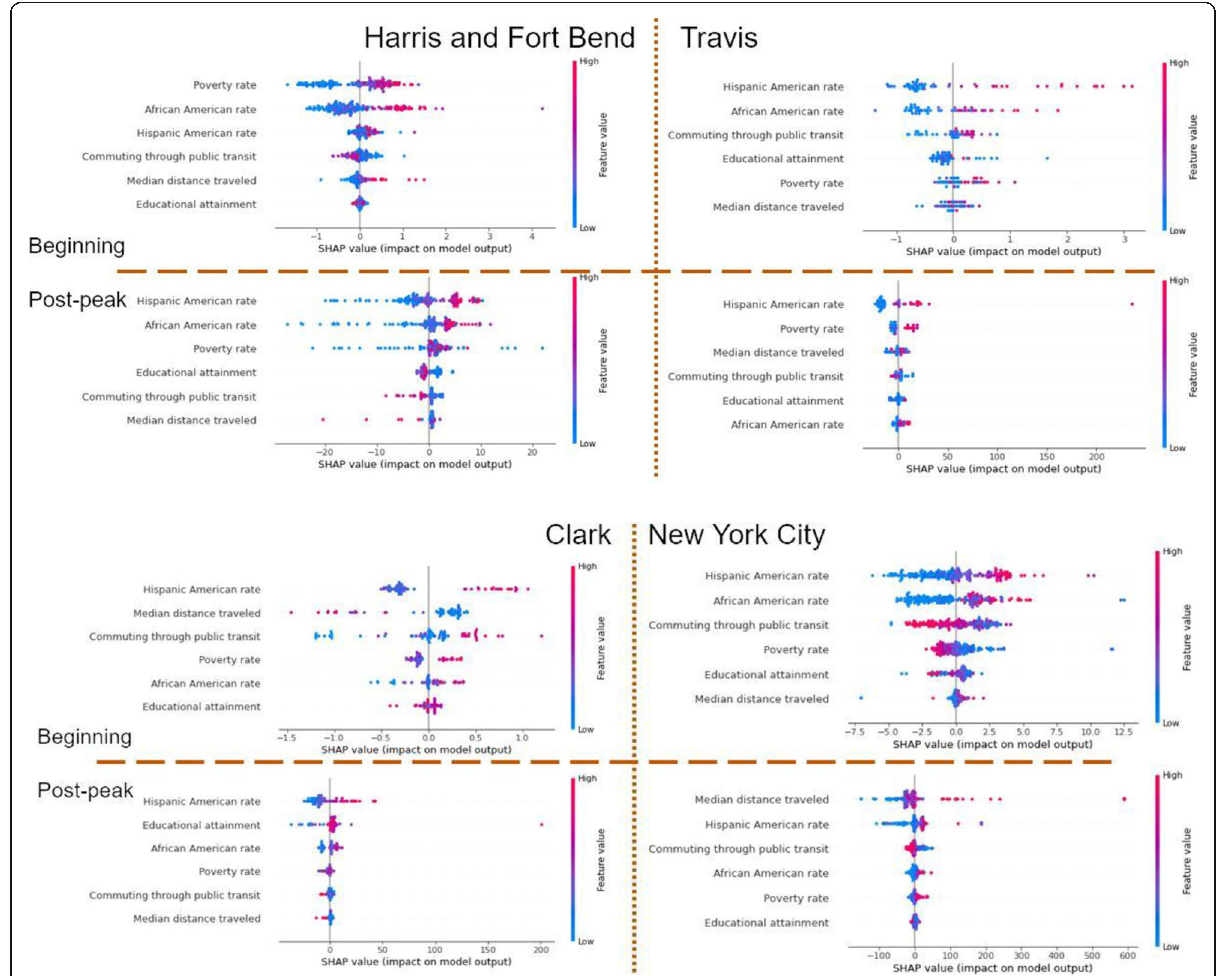
Fig. 7 Distribution of each feature